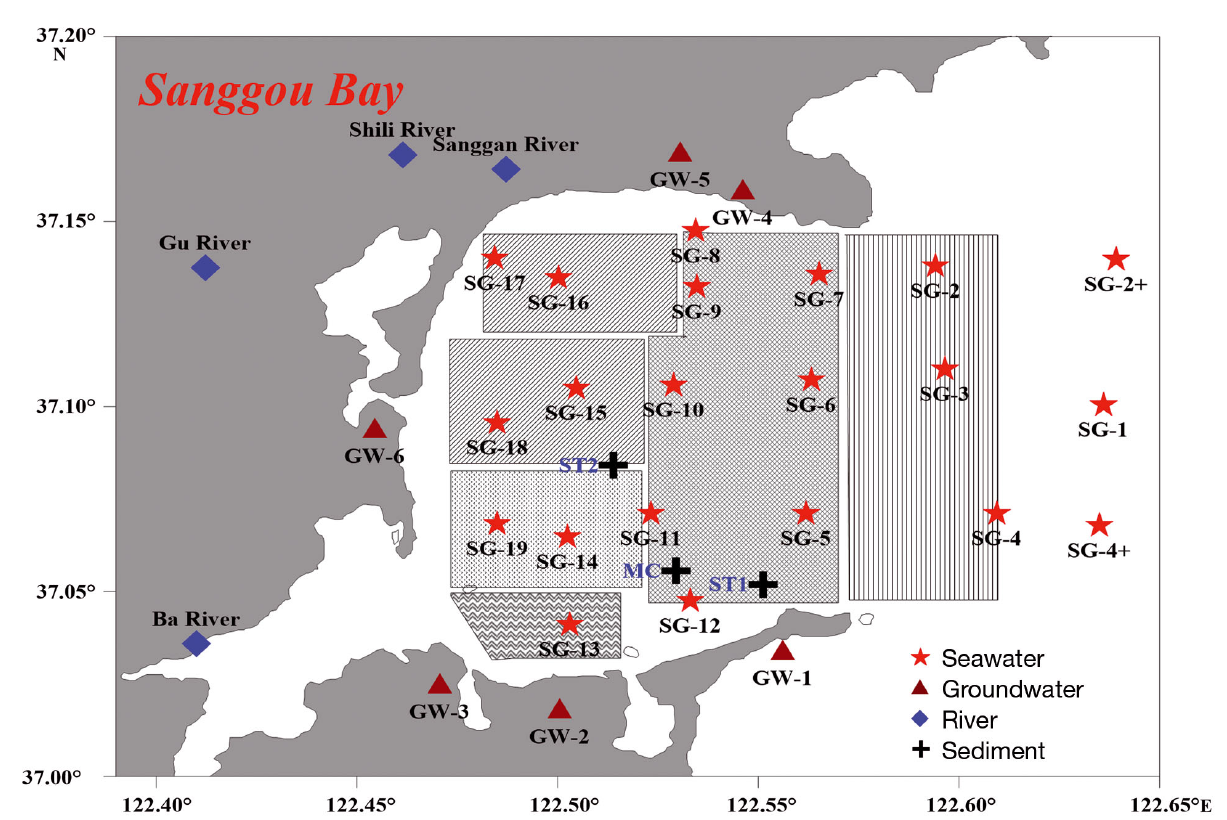
Fig. 2. Sampling locations in Sanggou Bay. Polygons delineate aquaculture types, see Fig.